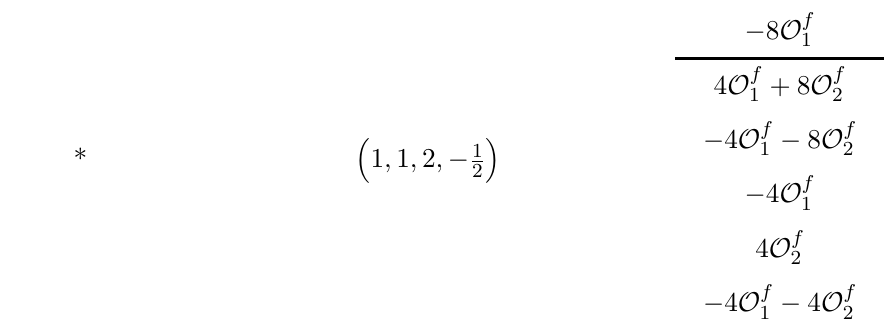
Table 29. UV resonance of topology dim8-bosonic-5. “*” in front of each row indicates topologies with nonrenormalizable